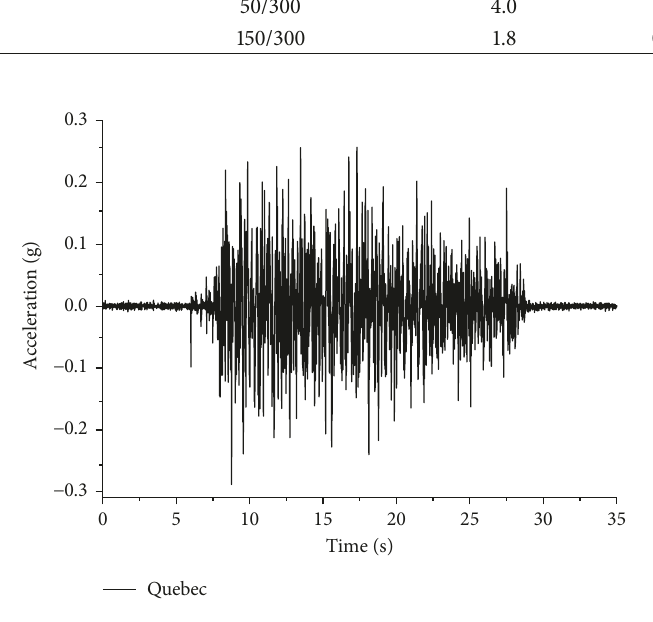
Figure 4: Ground motion of Quebec.